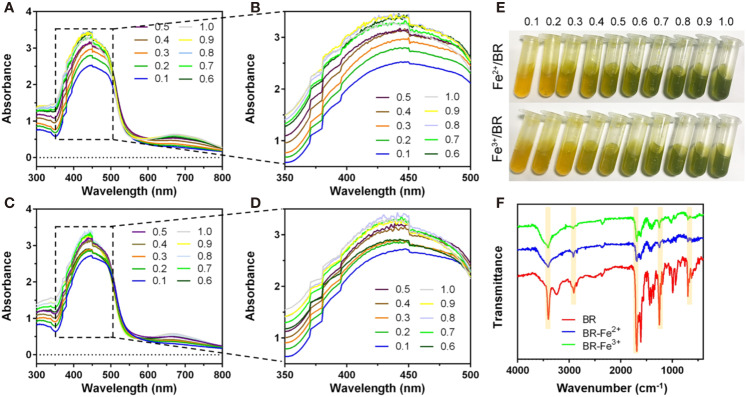
Iron chelation property of bilirubin. UV-Vis spectra for the chelation of Fe(II) (A, B) and Fe(III) (C, D) by bilirubin at the different molar ratios. (E) Images of formed bilirubin-iron complex at the different molar ratios. (F) IR spectra for Fe(II)-bilirubin and Fe(III)-bilirubin complexes.